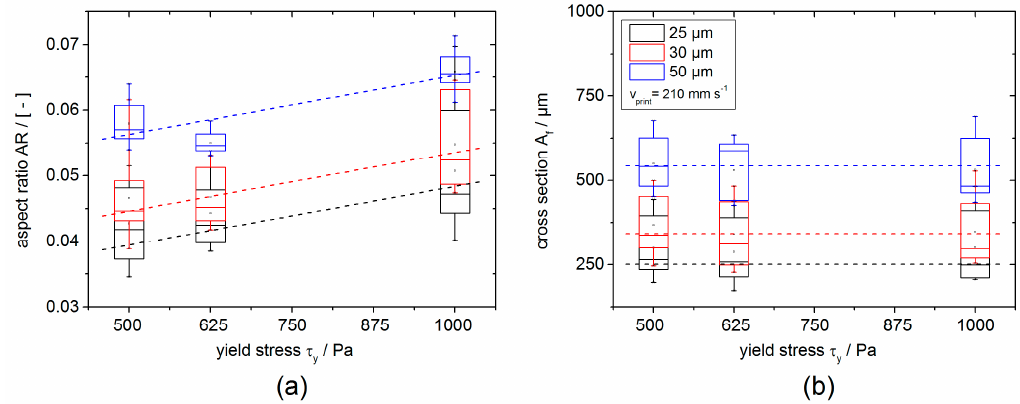
Figure 12. ( a ) Aspect ratio AR determined for M1, M2, and M3 at 25, 30, and 50 µm finger openings and 210 mm s − 1 printing speed in relation to the yield stress; ( b ) Finger cross sections A f obtained for M1, M2, and M3 at 25, 30, and 50 µm finger openings and v print = 210 mm s − 1 as a function of yield stress.